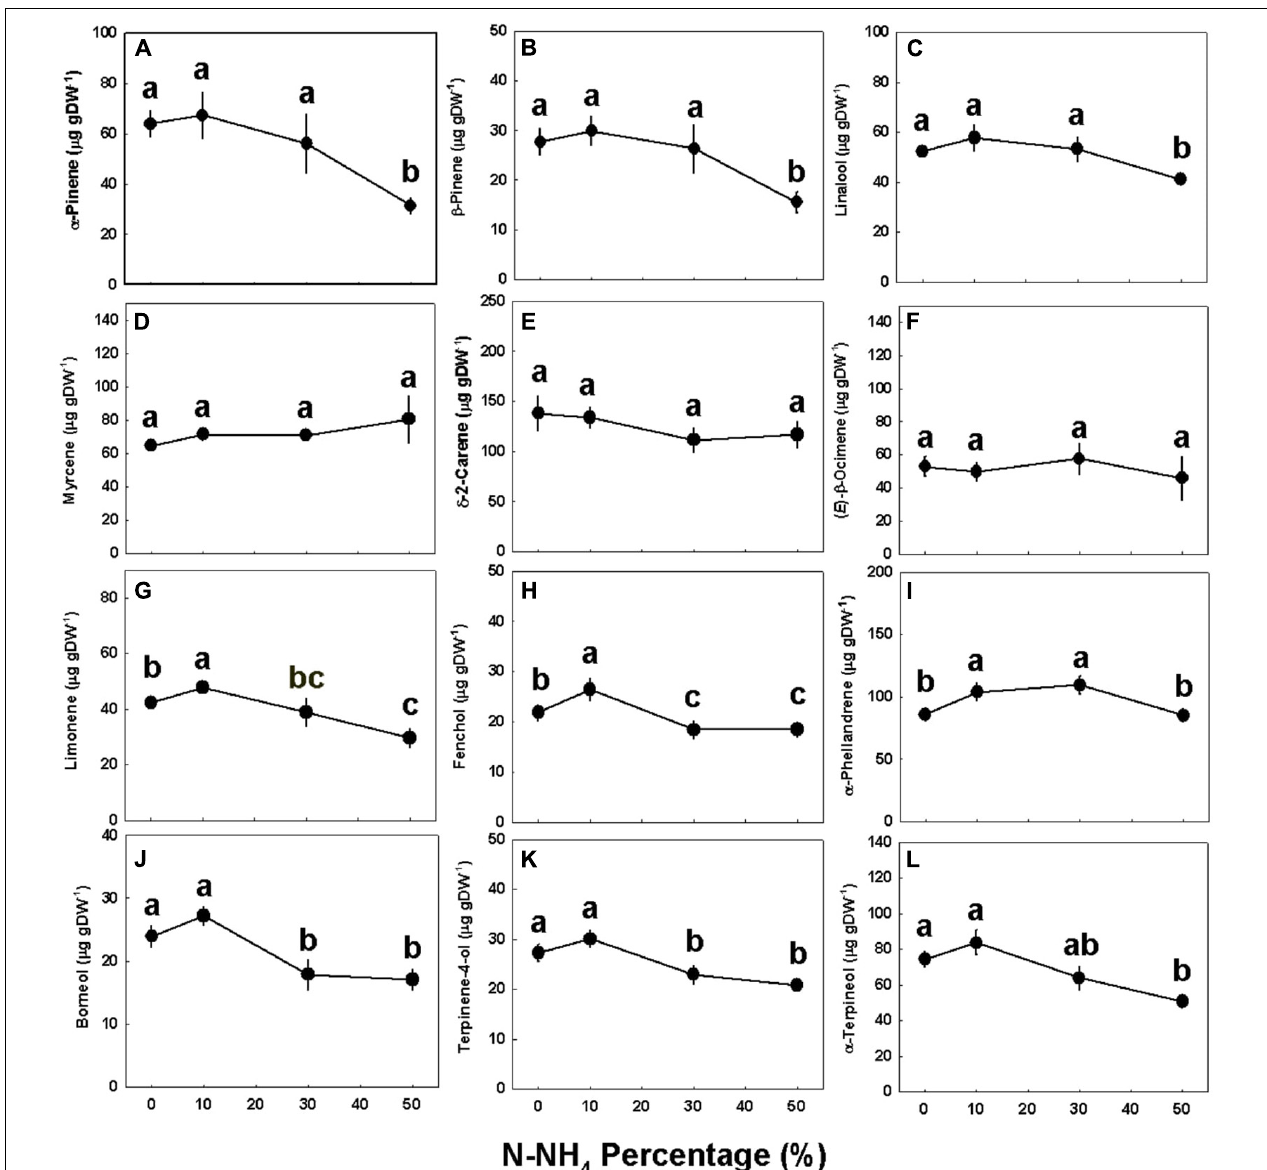
FIGURE 5 | Effect of NH 4 /NO 3 ratio on monoterpene concentration in medical cannabis plants. α -Pinene (A) , β -pinene (B) , linalool (C) , myrcene (D) , δ -2-carene (E) , ( E )- β -ocimene (F) , limonene (G) , fenchol (H) , α -phellandrene (I) , borneol (J) , terpinen-4-ol (K) , and α -terpineol (L) concentration in the top inflorescence. Presented data are averages ± SE ( n = 5). Different small letters above the means represent significant differences between treatments by Tukey HSD test at α =